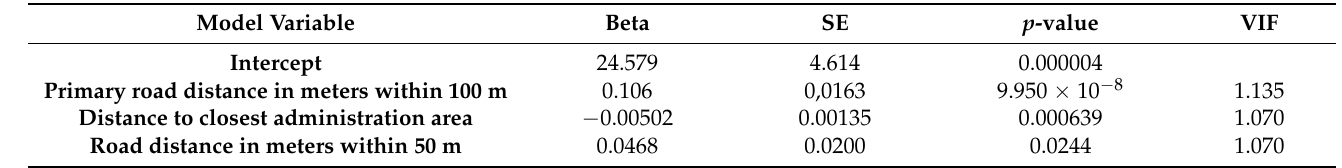
Table 4. Variables and their coefficients included in the final LUR model for NO x .